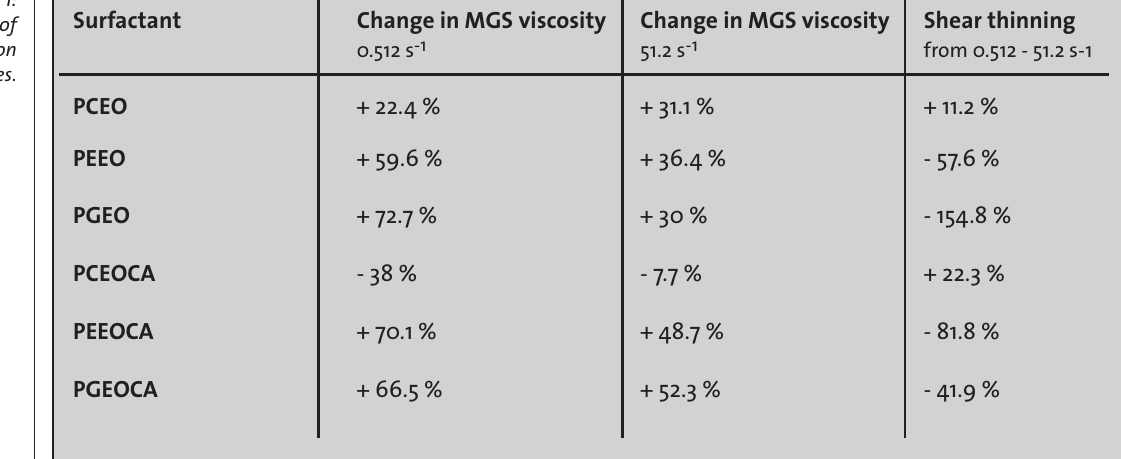
Table 1: Beneficial effects of eucalyptus oil on rheological properties.